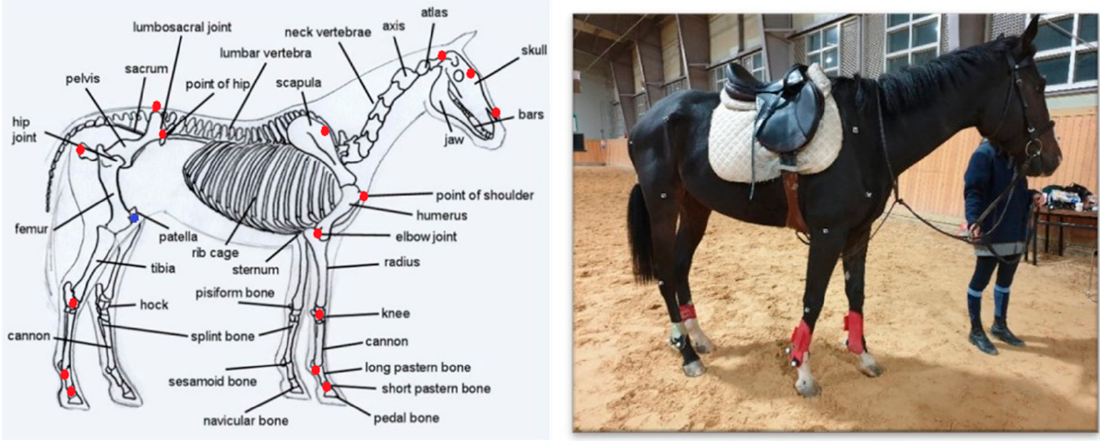
Figure 1. Reflective markers.